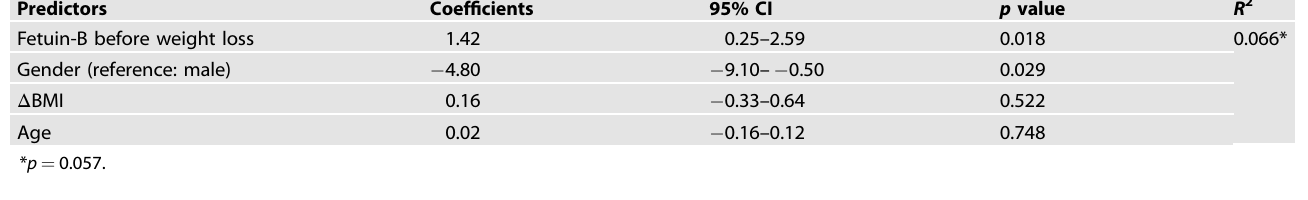
Table 3. Prediction of weight loss-induced change of insulin-mediated suppression of FFAs ( Δ FFA Supp ) by baseline Fetuin-B level and gender. Predictors